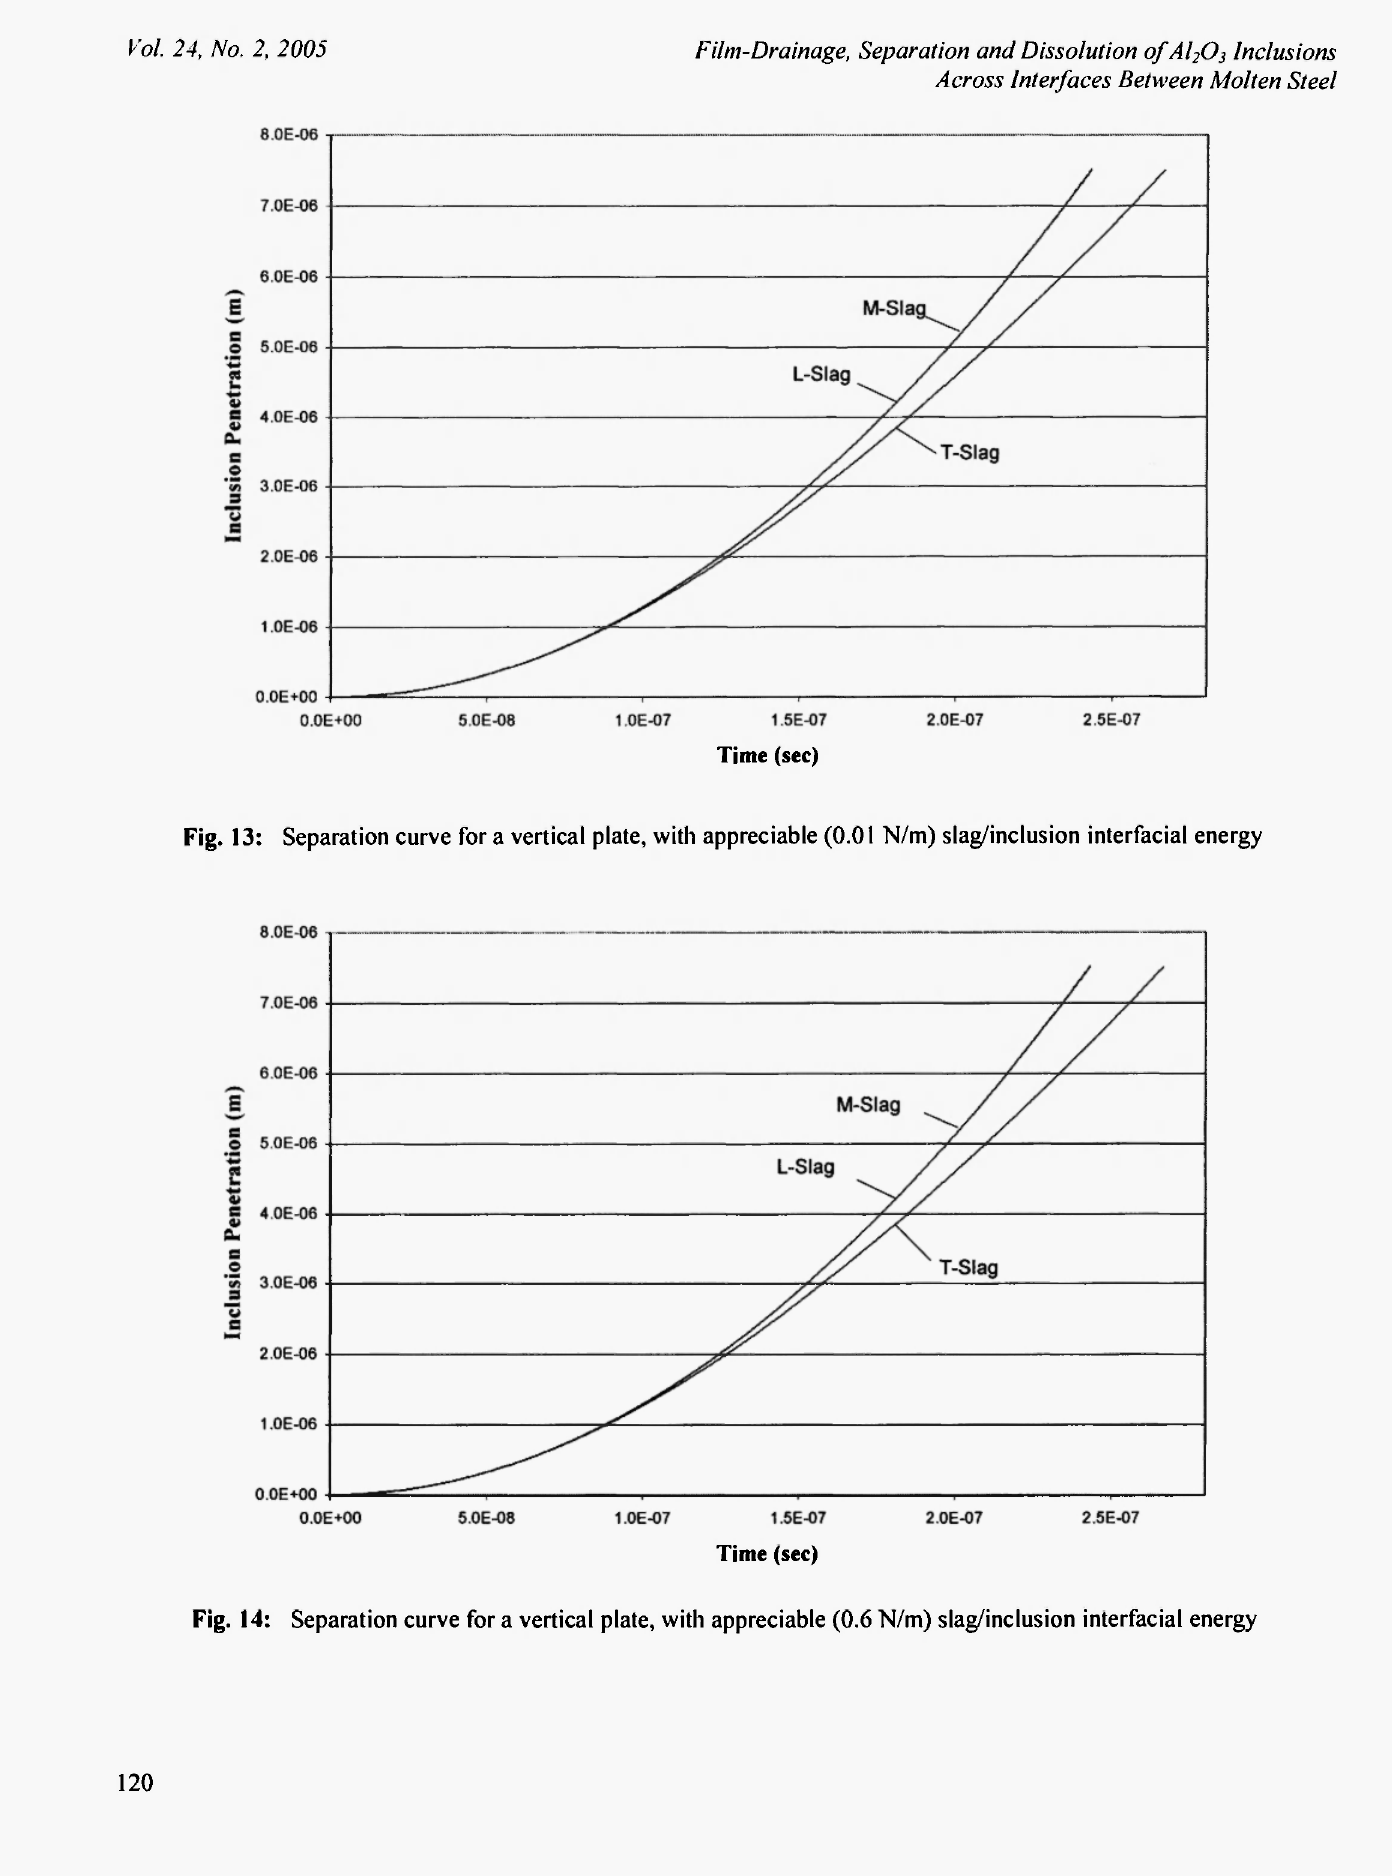
Fig. 13: Separation curve for a vertical plate, with appreciable (0.01 N/m) slag/inclusion interfacial energy